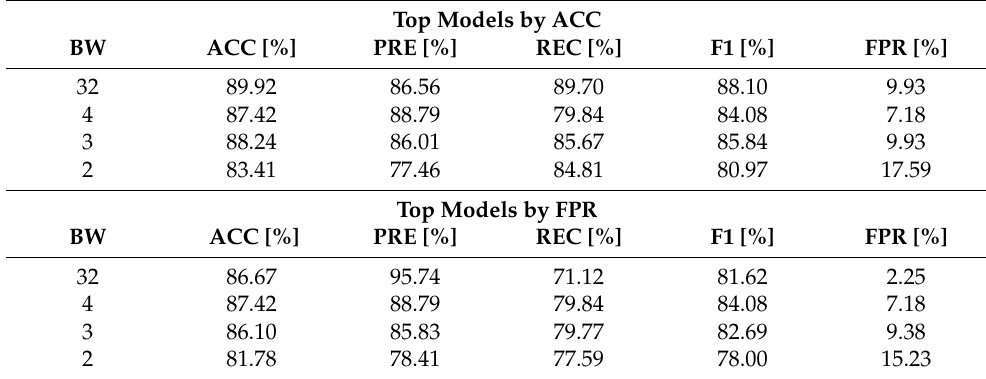
Table 4. Results of cloud coverage classification for best-performed models employing full L8-D